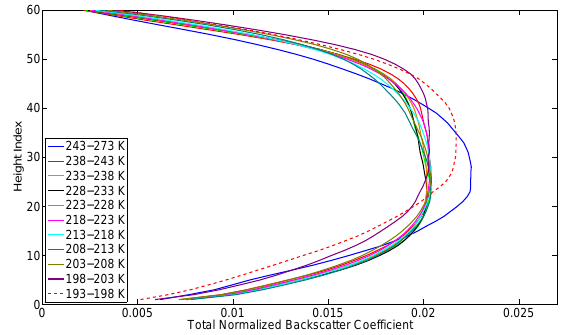
Fig. 9. Mean BSPs for cirrus clouds with selected midlayer temperature intervals. Tropical regions at daytime are considered.